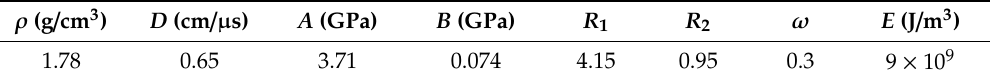
Table 1. Parameters’ values of RDX (Royal Demolition Explosive). Table 1. Parameters ’ values of RDX (Royal Demolition Explosive).